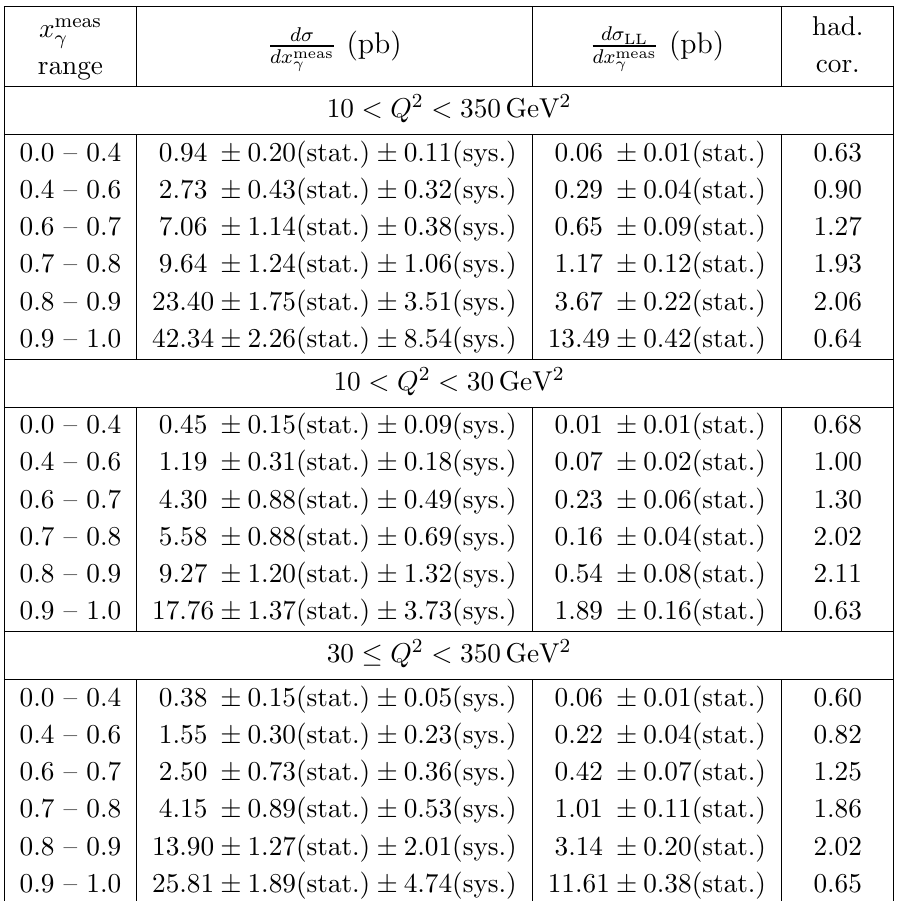
Table 1 . Measured di(cid:11)erential cross-section d(cid:27) . The quoted systematic uncertainty includes dx meas (cid:13) all the components added in quadrature. The calculated LL contribution which was added to the Pythia and AFG calculations is also listed, and the hadronisation correction calculated for the AFG predictions. Di(cid:11)erences between cross sections in the (cid:12)rst section and the sum of the corresponding values in the second and third sections are of statistical